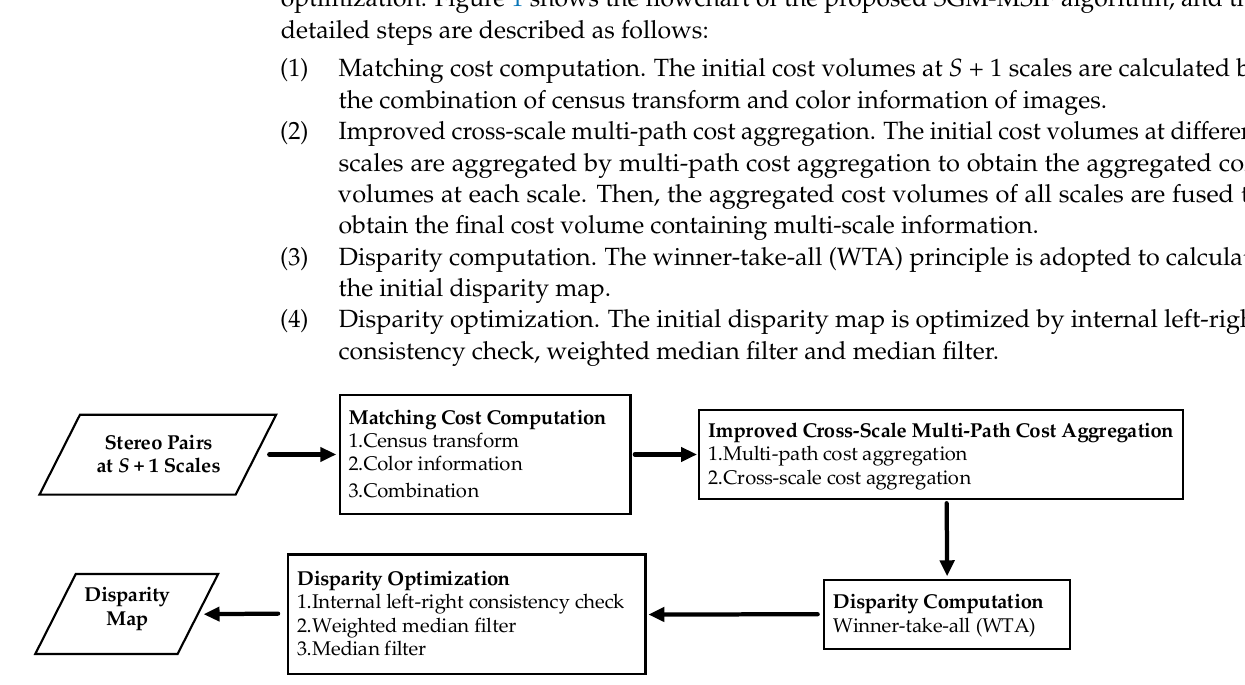
Figure 1. The flowchart of SGM-MSIF